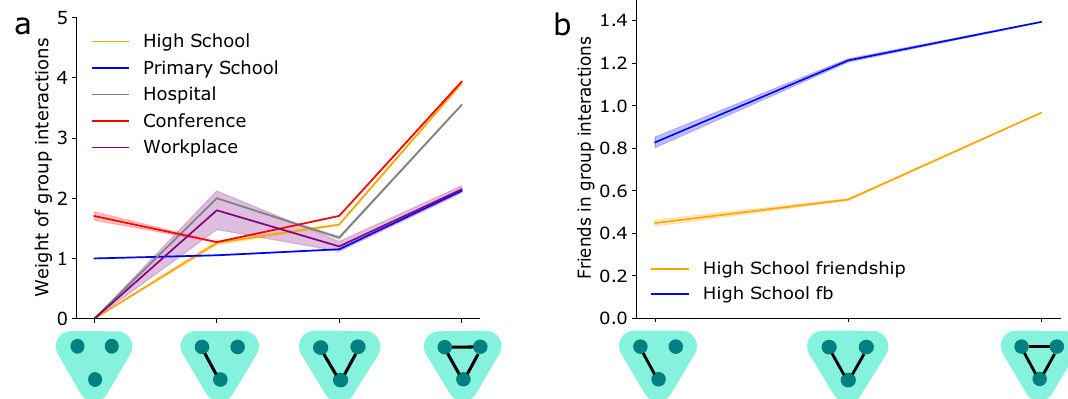
Fig. 5 Structural reinforcement. A rich supporting nested structure of pairwise links makes group interactions stronger. In both panels, stronger levels of connectivity are observed when the number of dyadic interactions increases. a Mean weight of each group interaction (i.e., the number of times each group interaction occurs) as a function of the number of its nested pairwise links. b Mean number of friends (certi fi ed by a Facebook friendship or by a questionnaire) in group interactions as a function of the number of their nested pairwise links. In both panels, the shaded area represents the standard error of the